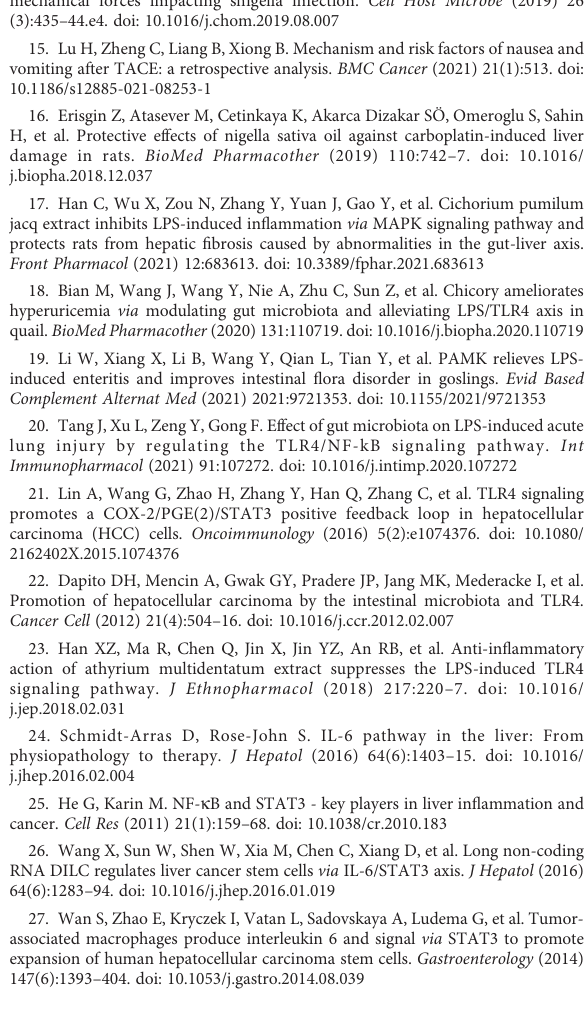
SUPPLEMENTARY FIGURE 1 (A, B) Clustering tree Based on the Weighted UniFrac distance in phylum and order level. (C) Analysis of different species of microbial.